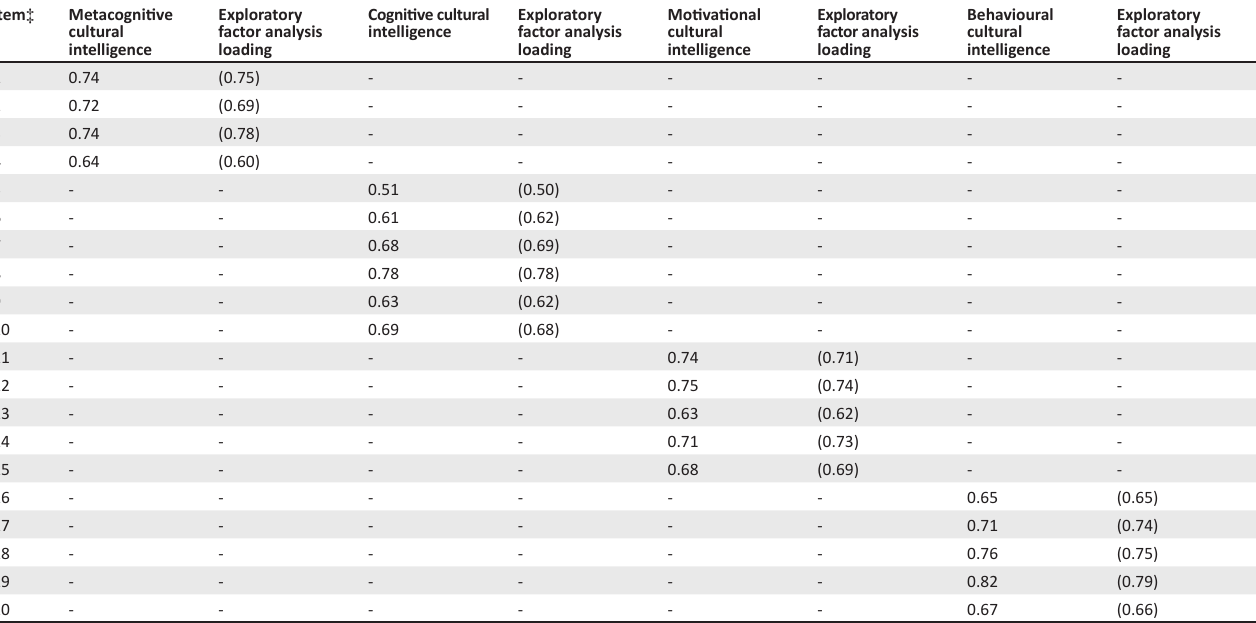
TABLE 3: Factor loading estimates † for the cultural intelligence scale from confirmatory and exploratory factor analysis. Item ‡ Metacognitive cultural